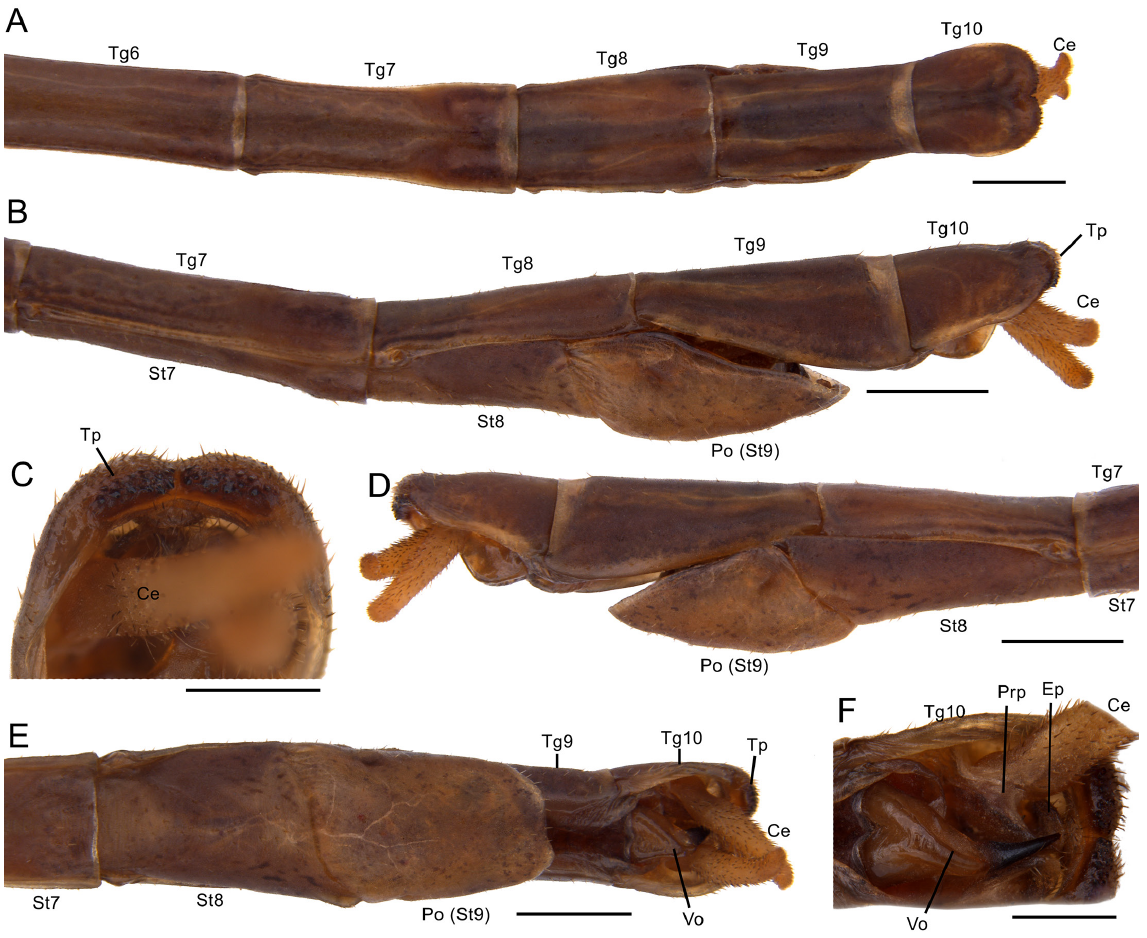
Fig. 32. Arumatia aramatia Ghirotto gen. et sp. nov., paratype, ♂ (MZUSP 1322), terminalia morphology. A . Dorsal view. B . Left side lateral view. C . Detail of thorn pads, ventro-posterior view. D . Right side lateral view. E . Ventral view. F . Detail of vomer, ventral view. Abbreviations: Ce = cercus; Ep = epiproct; Po = poculum; Prp = paraproct; St = sternum; Tg = tergum; Tp = thorn pads; Vo = vomer. Scale bars: A–B, D–E = 1 mm; C, F = 0.5